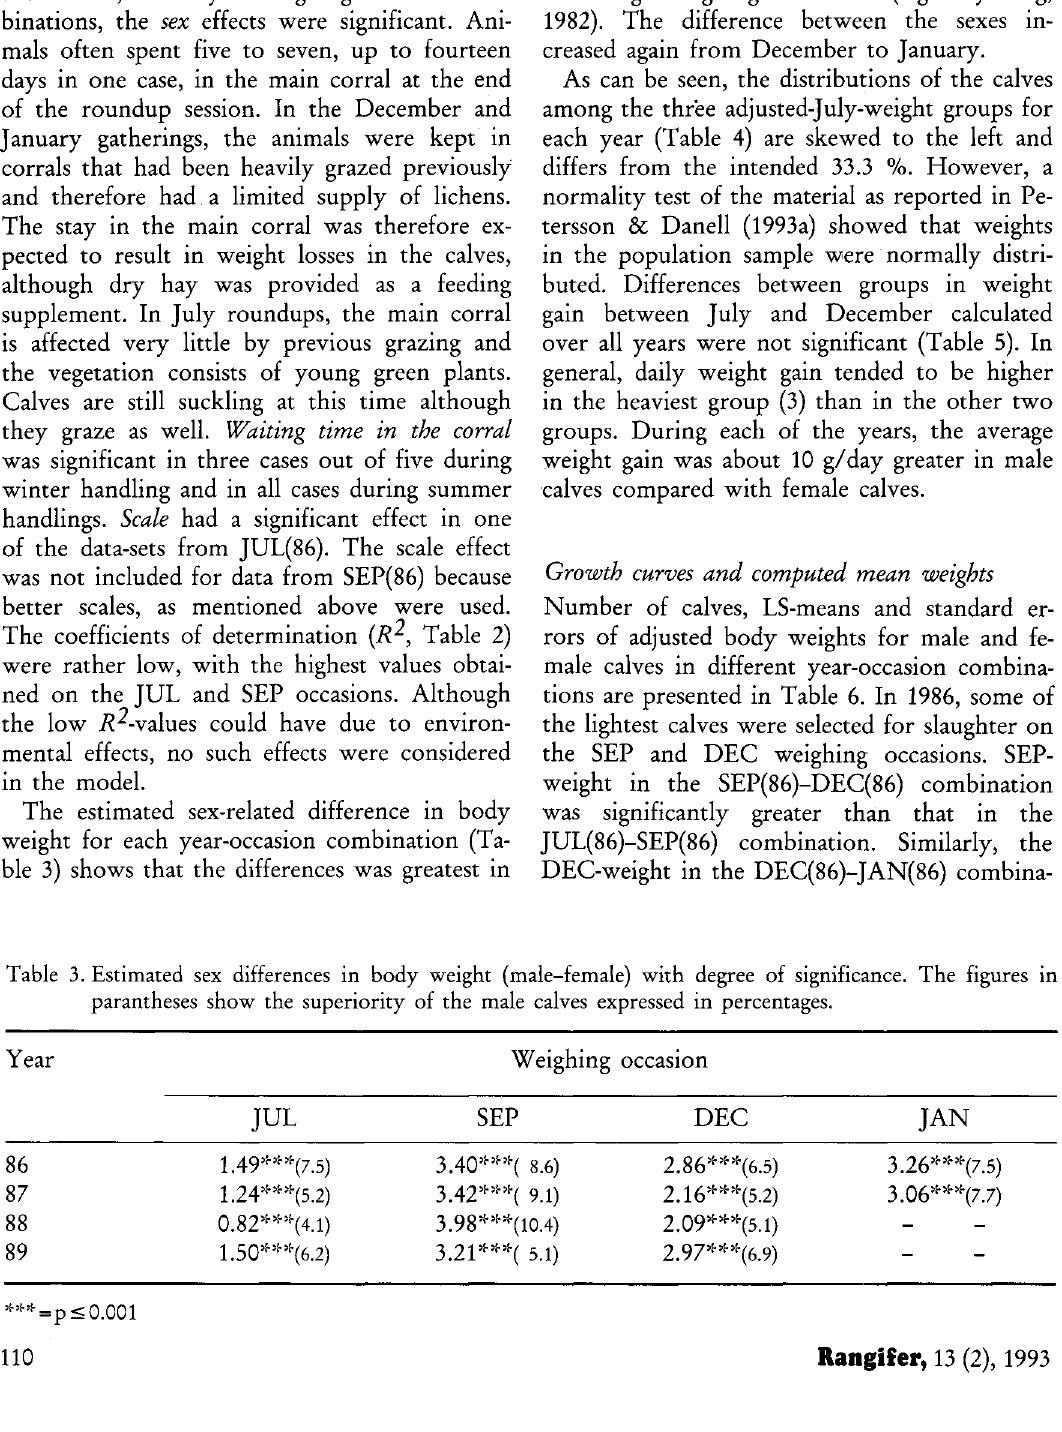
Table 3. Estimated sex differences in body weight (male-female) with degree of significance. The figures in parantheses show the superiority of the male calves expressed in